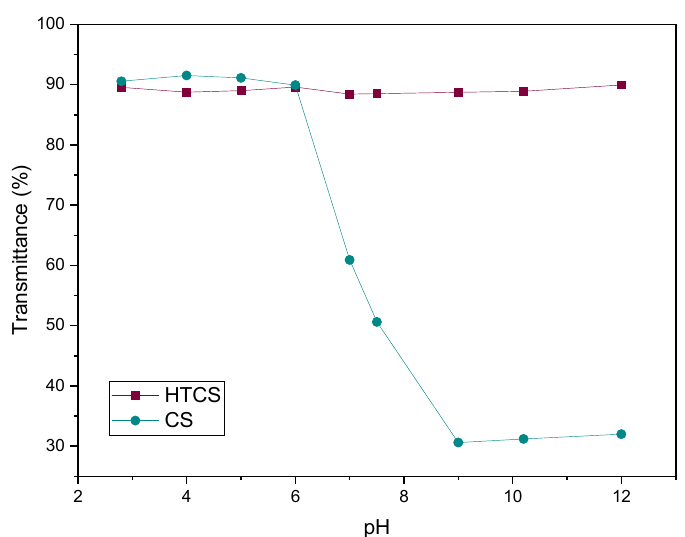
Figure 3. The water solubility of CS and HTCS at pH ranging from 3 to 12. The transmittance of the polymeric solution was measured with